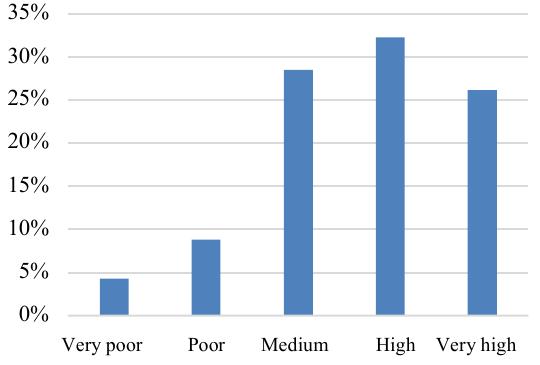
Fig. 6. People desire in CE aggregation. Fig. 7 refers to the answers related to the